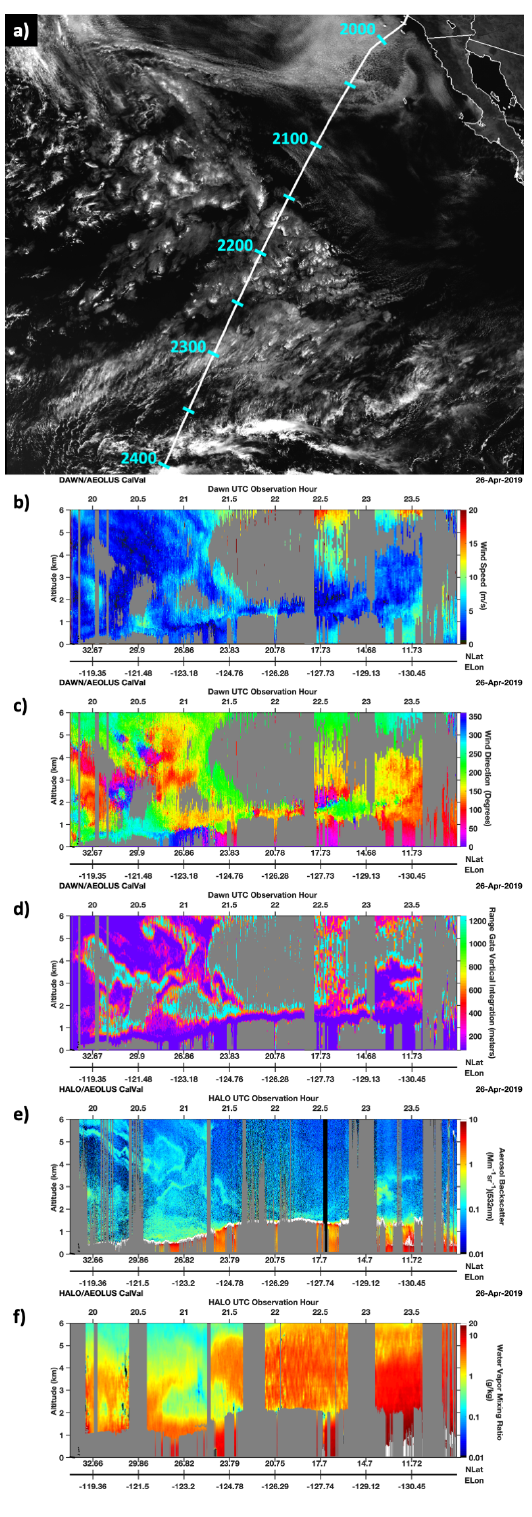
Figure 10. (a) GOES-17 0.64µm visible at 2200UTC on 25 April 2019 overlain with a nearly 4h duration DC-8 flight track over stratocu and tropical convection. (b, c) DAWN wind speed and direction. The DAWN wind speed color scale was compressed to 0–20ms − 1 to accentuate wind speed variations along the flight track. Only data between 0 and 6km altitude are shown. (d) The depth of vertical signal integration required to achieve sufficient signal for a DAWN wind retrieval. (e, f) HALO 532nm aerosol backscatter and water vapor mixing